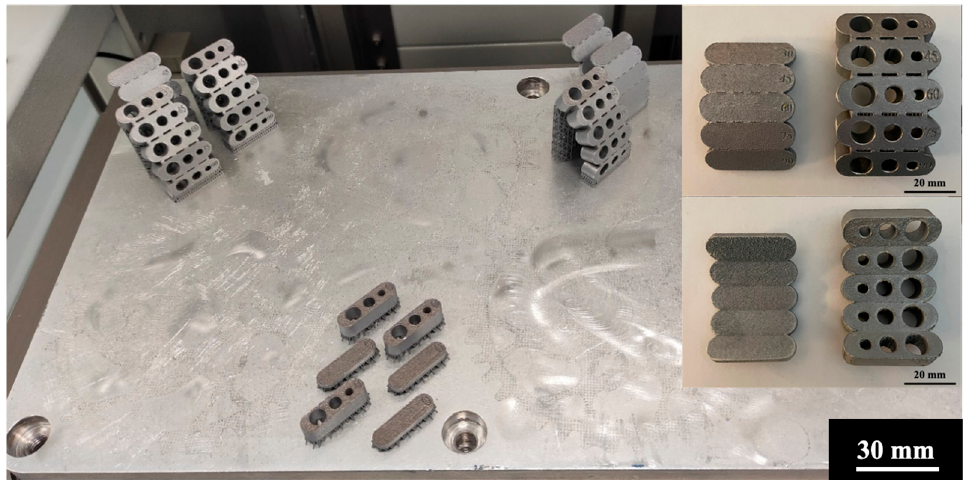
Figure 4. L-PBF-produced structures on the build platform. The figure presents also some insets showing the surface quality of the produced